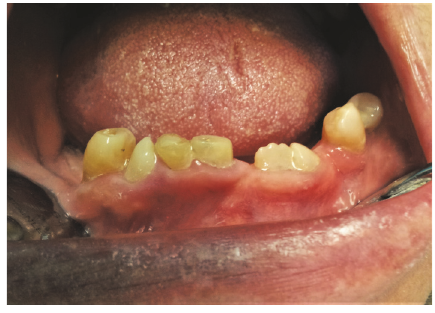
Figure 2: The initial situation at greater magnification.